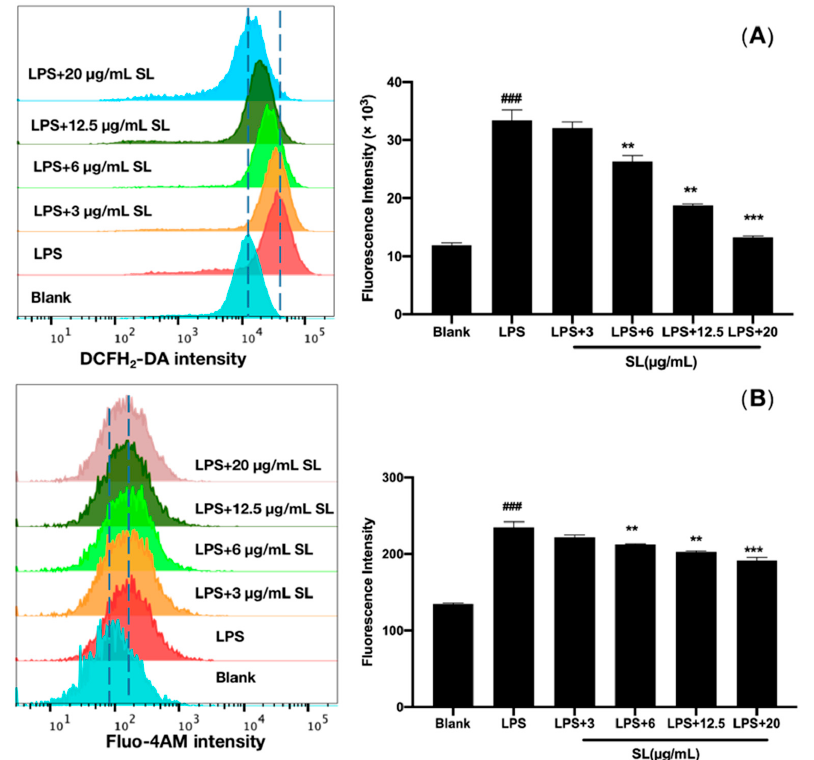
Figure 4. Effect of SLs on the LPS-induced levels of ROS and Ca 2+ in RAW264.7 cells. Cells were incubated with 1 μ g/mL of LPS with or without SL for 8 h. Flow cytometry was employed to deter-